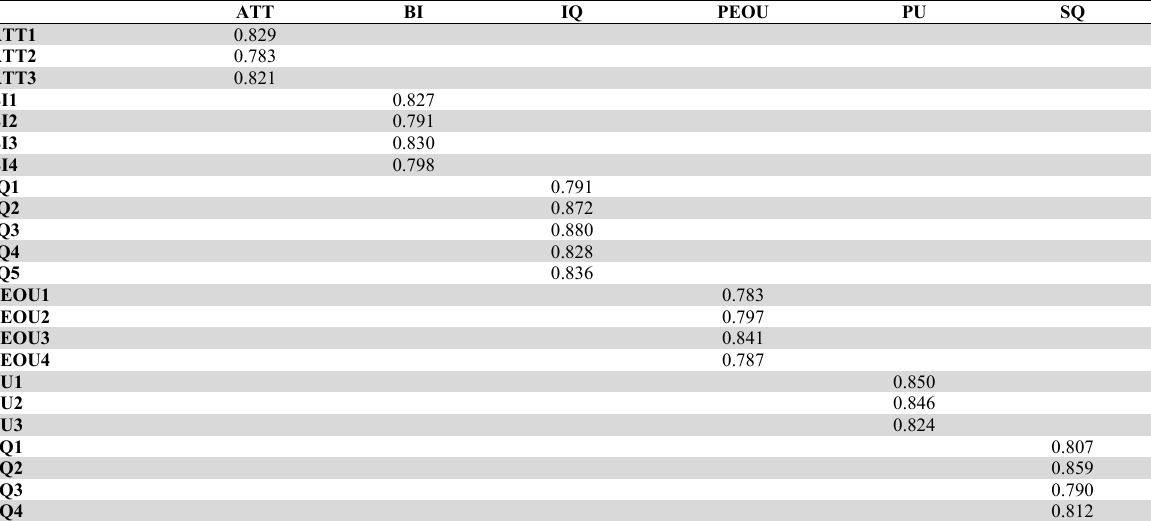
Cross Loading Value